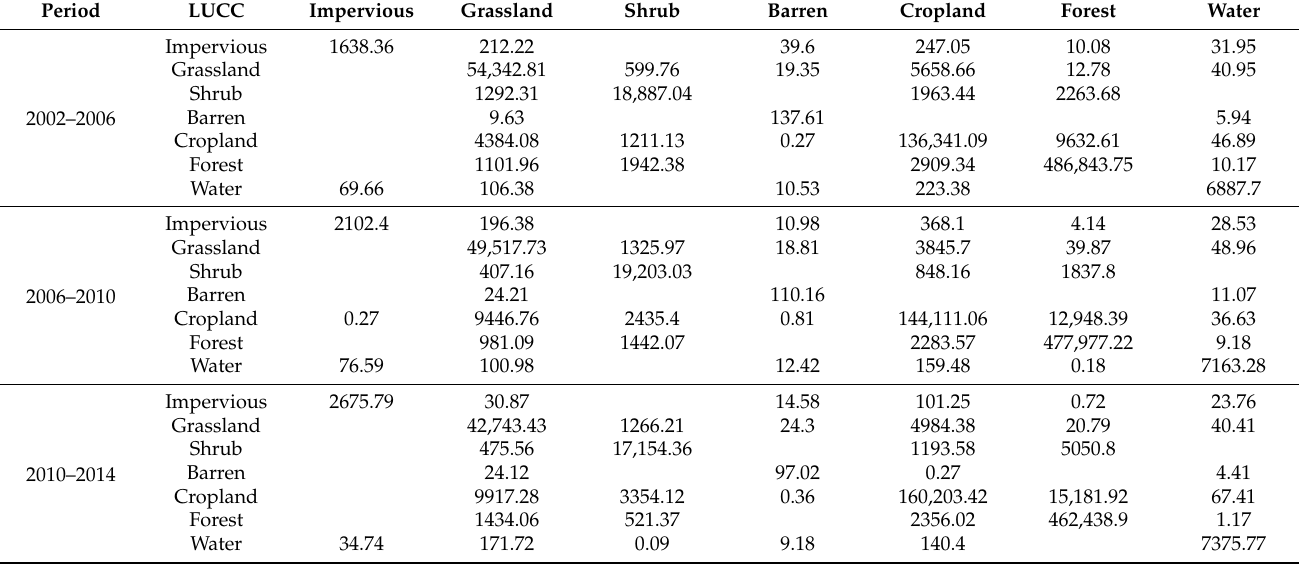
Table A1. Land use transfer matrix for the study area from 2002 to